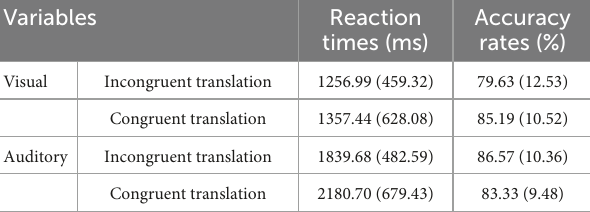
TABLE 4 Reaction times and accuracy rates in each condition of the translational congruency experiment.